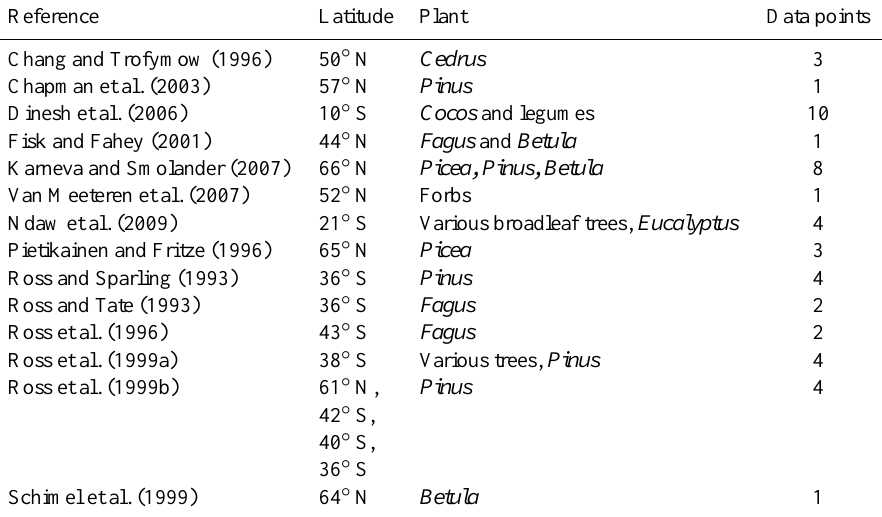
Table 1. References considered in the analysis together with the latitude of the study site, the plant genus from which the litter was derived, and the number of data points obtained from each reference.